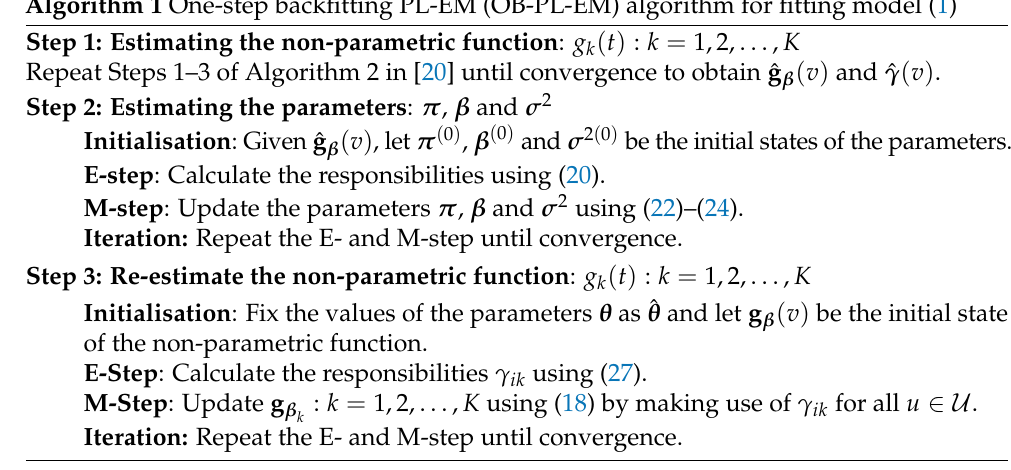
Algorithm 1 One-step backfitting PL-EM (OB-PL-EM) algorithm for fitting model (1)